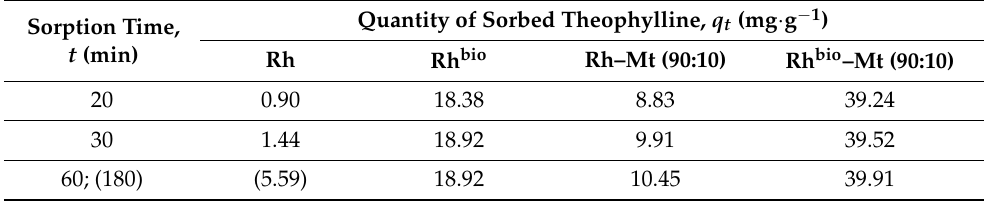
Table 3. Theophylline sorption by initial and modified substrates (40 ◦ C, pH 5). Sorption